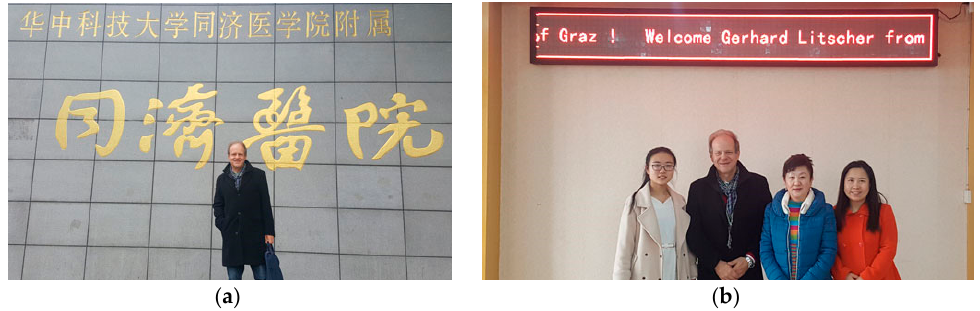
Figure 34. ( a , b ) Huazhong University of Science and Technology, Tongji Medical College. Professor G. Litscher with representatives from the School of Nursing. Wuhan, China, 6 December 2017.